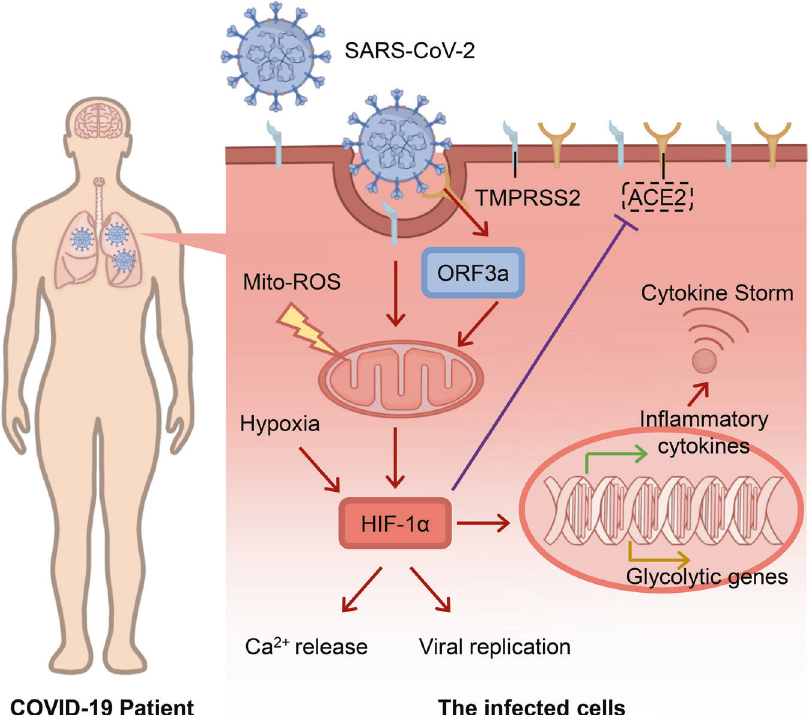
Fig. 4 Role of HIF-1 α in hypixa signaling in COVID-19. When SARS-CoV-2 entering host cells, viral ORF3a protein induces HIF-1 α expression through triggering mitochondrial reactive oxygen species (ROS) activation. The accumulated HIF-1 α stimulates Ca 2 + release, promotes viral replication and enhances glycolytic and in fl ammatory genes, which leads to a cytokine